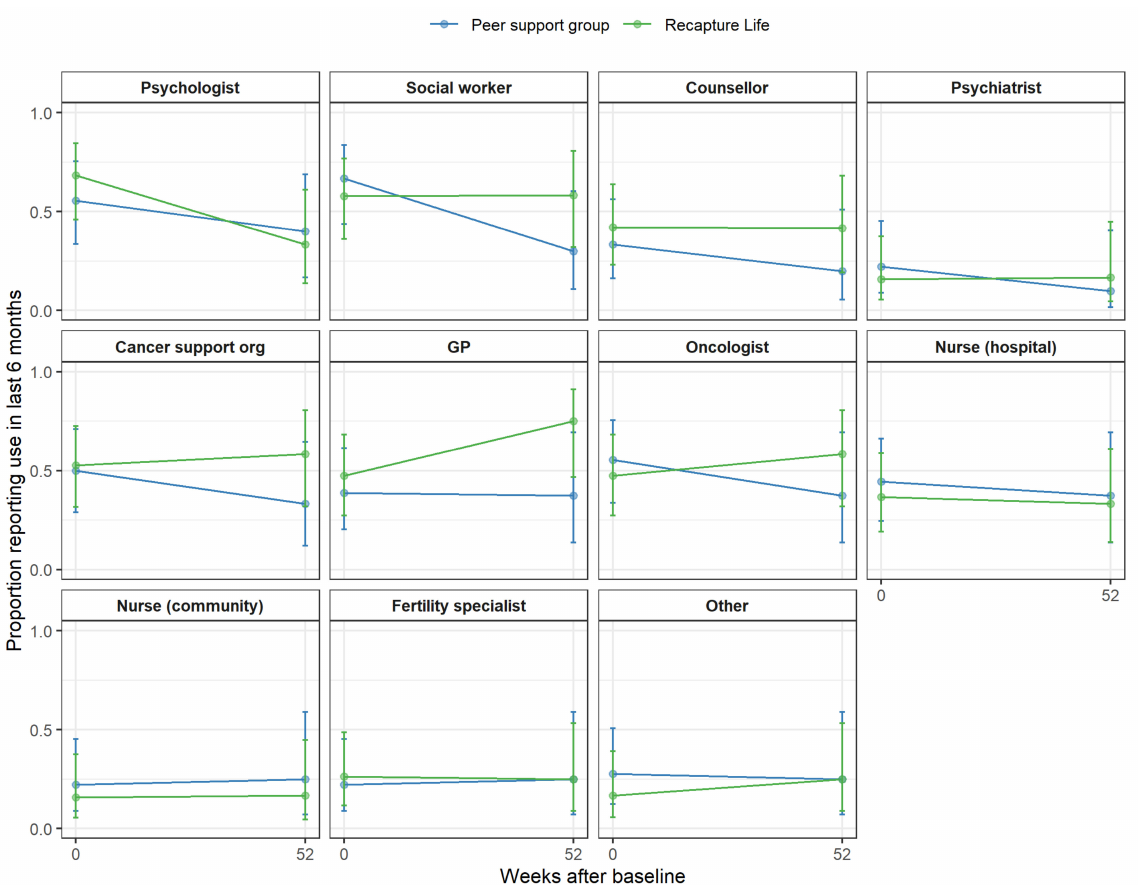
Figure 6. AYAs’ health service use over the past six months by healthcare professional type. Note. Individual scores are displayed, overlaid with thicker lines showing group-specific means and 95% confidence